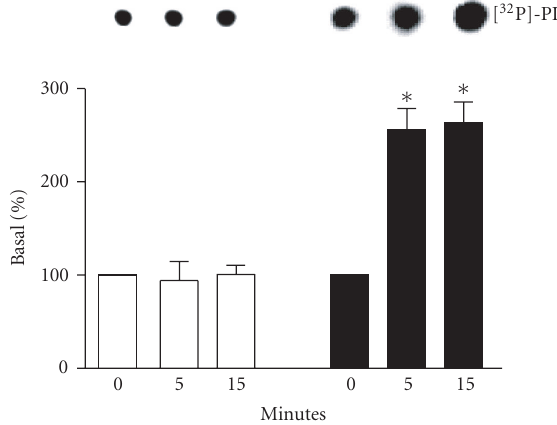
Figure 1: PI-3K activity with β -AR stimulation . HEK 293 cells were transfected with β 1 -AR or β 2 -AR. Forty-eight hours after transfection, cells were stimulated with 1 μ M isoproterenol for the indicated times. PI-3K activity was determined by the level of [ 32 P ]-PI produced by the stimulation of β 1 -AR ( (cid:2) ) or β 2 -AR ( (cid:3) ) expressing cells. Top panel is a representative autoradiograph of TLC separation ( n = 4-5). Data from these experiments is quantitated in the bottom panel as described in Section 2. ∗ P < . 05 versus 0